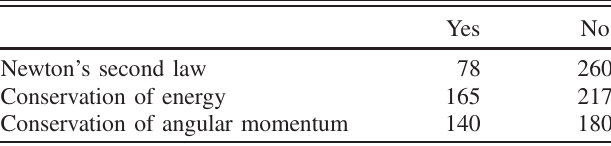
TABLE II. Student responses to the question “ Have you worked on the corresponding online tutorial? ” in large enrollment classes as a self-study